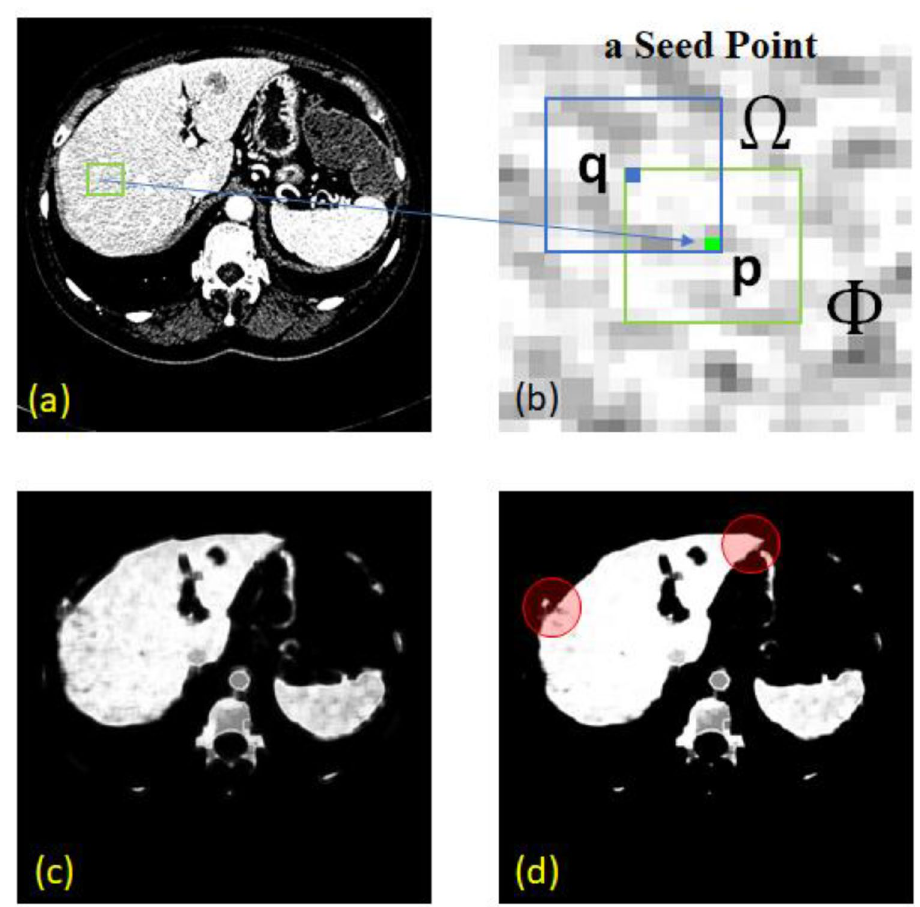
Figure 3. An example of applying probability map and relaxation labeling. The original CT image ( a ) with a seed point (green) is shown in ( b ), the probability map image and RL enhanced results are shown in ( c ) and ( d ), respectively. The probability values from 0 to 1 are scaled to 0 to 255 for visualization